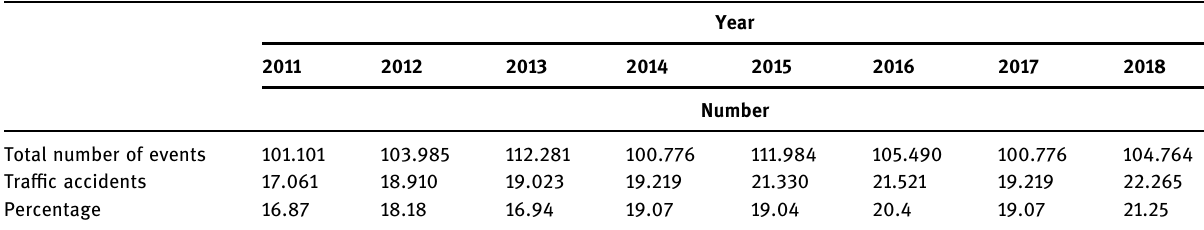
Table 3: Number of events and accidents with fi re protection unit intervention in the years 2011 – 2018